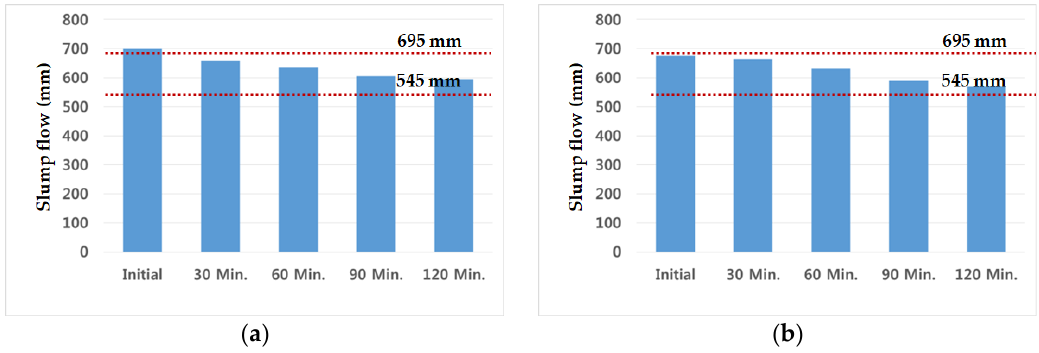
Figure 6. Slump flow test ( a ) C40-3 (GGBS 60%, Baxel PC 650) ( b ) C40-4 (GGBS 65%, Baxel PC 650).